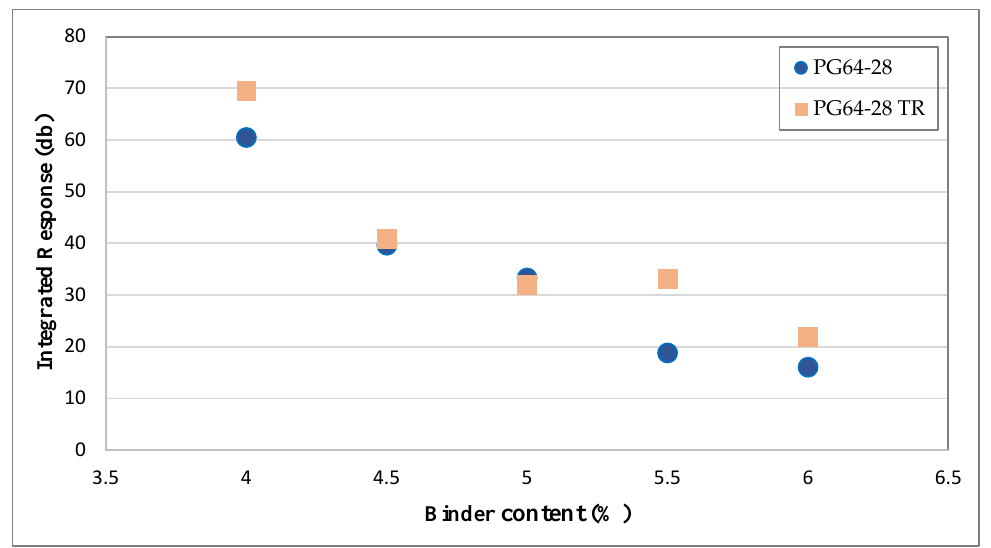
Figure 5. Wave integrated response trend with binder content for PG 64-28 mix.